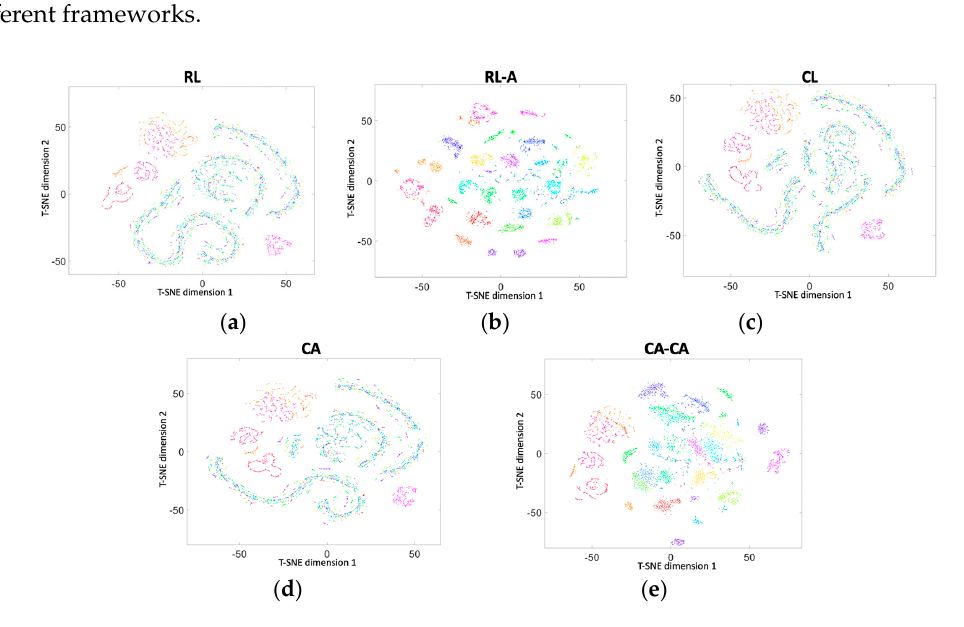
Figure 12. Two-dimensional t-SNE (t-distributed random neighbor embedding) visualization of the data in ( a ) RL, ( b ) RL-A, ( c ) CL, ( d ) our proposed CA, and ( e ) our proposed